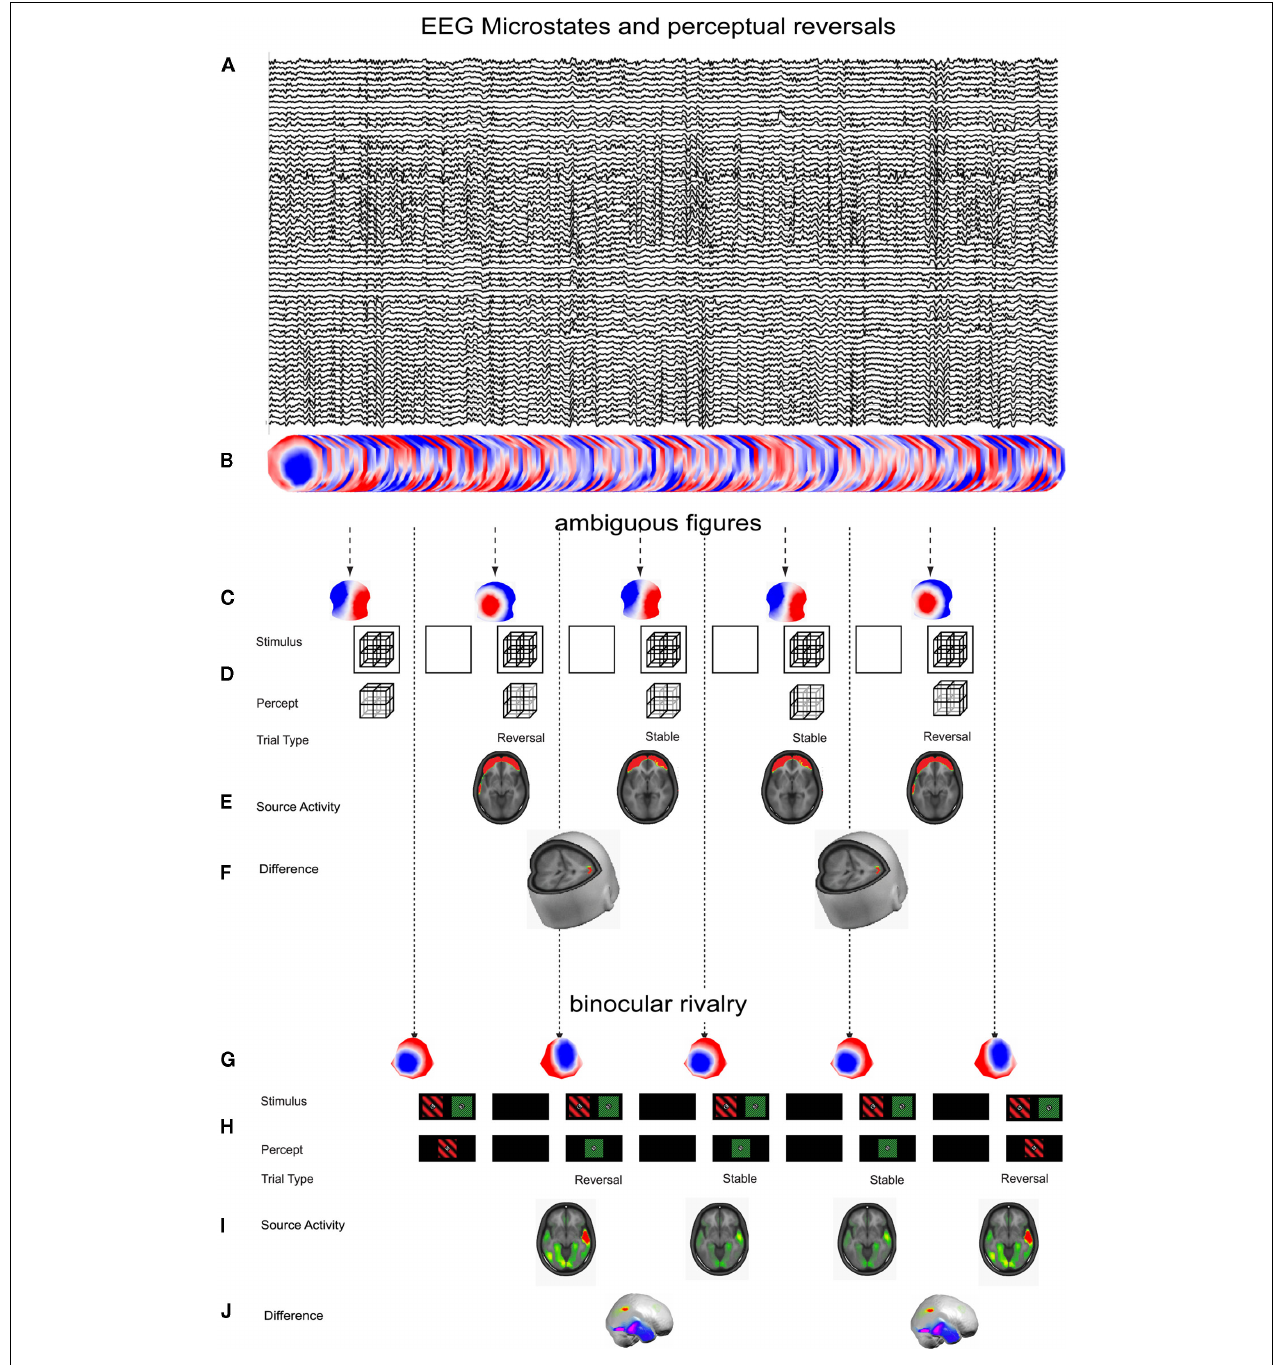
differences reveals activity in right inferior parietal cortex. (G) Momentary pre-stimulus microstates that discern perceptual reversals from perceptual non-reversals during binocular rivalry (from Britz et al., 2011). (H) The perceptual awareness of a binocular rivalry stimulus alternates stochastically as a function of the pre-stimulus microstate depicted in (G) . (I) Source estimates of the concomitant neuronal generators of the reversal-related pre-stimulus microstates reveal activity in bilateral occipital and temporal areas. (J) Statistical assessment of their differences reveals increased activity in right inferior parietal cortex preceding perceptual reversals and in bilateral inferior temporal areas preceding perceptual